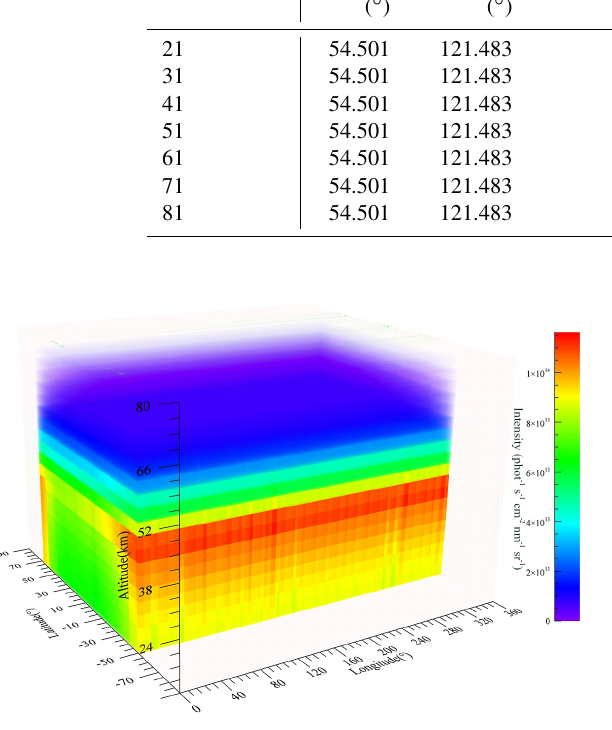
Figure 11. The simulated observation radiance received by SHS2 at the time of T2 under the different